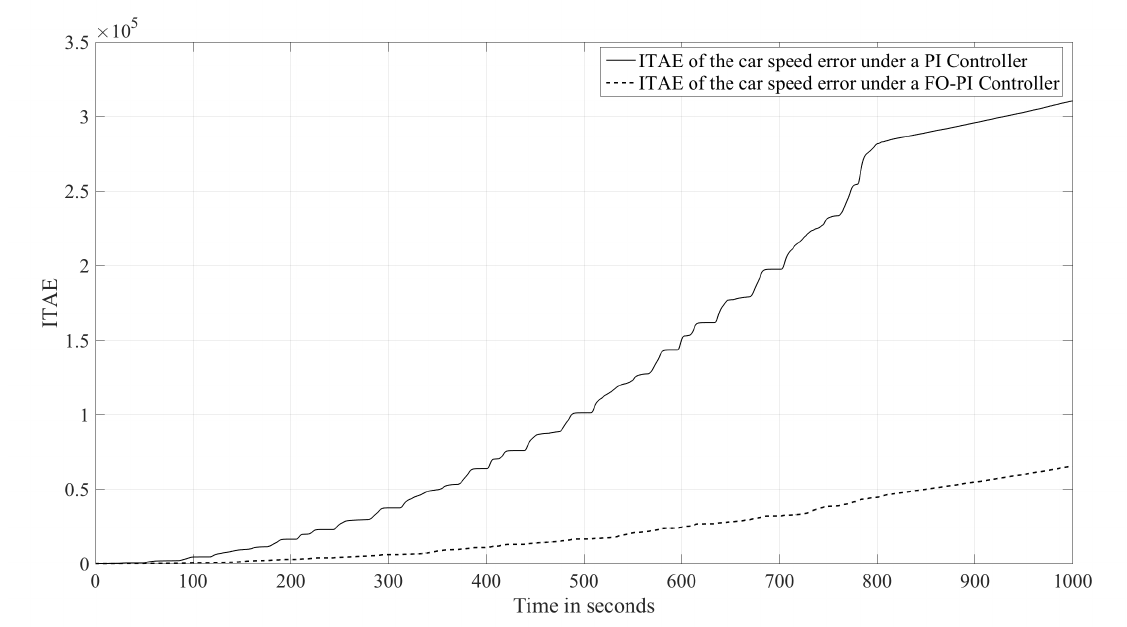
Figure 14. ITAE of the car speed with the system under both